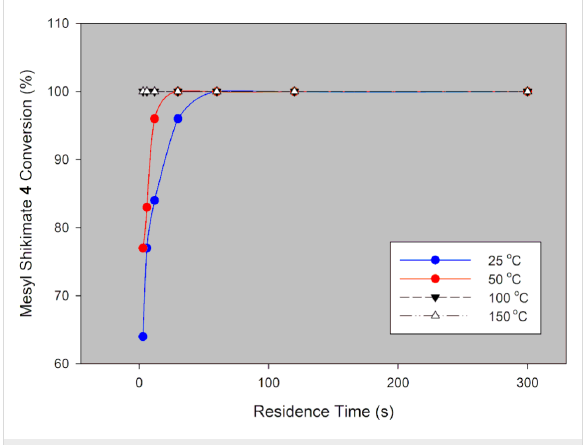
Figure 11: Mesyl shikimate azidation conversion in a continuous-flow system using